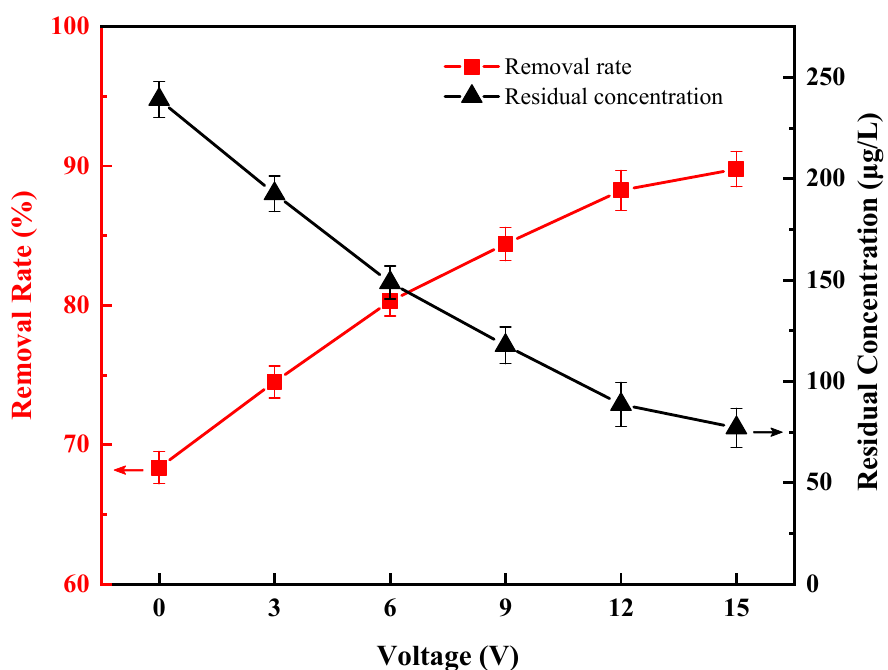
Figure 7. Effect of voltage on direct removal of Anabaena by DEP.